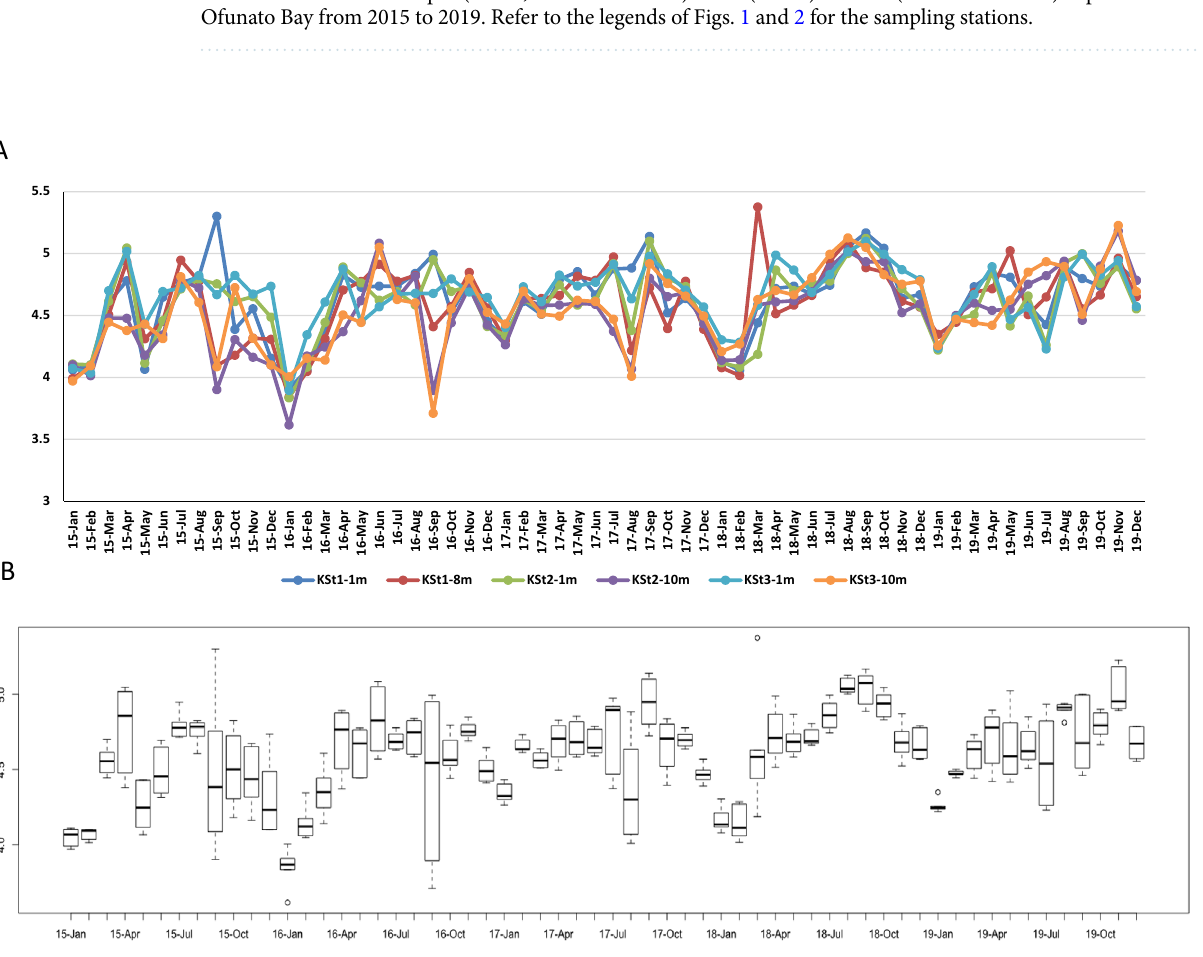
Figure 4. Seasonal changes in bacterial community biodiversity in Ofunato Bay plotted with the Shannon– Weaver diversity index. Seawater samples were collected monthly from the 1 m (KSt. 1, KSt. 2 and KSt. 3) and 8 (KSt. 1) or 10 m (KSt. 2 and KSt. 3) depths in Ofunato Bay from 2015 to 2019. Panels ( A ) and ( B ) show Shannon’s diversity index at three stations and two depths and the index from combined data for each month, respectively. Refer to the legend of Fig. 1 for the sampling